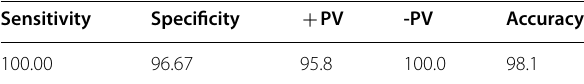
Table 16 Showing results of multi-parametric MRI with biopsy